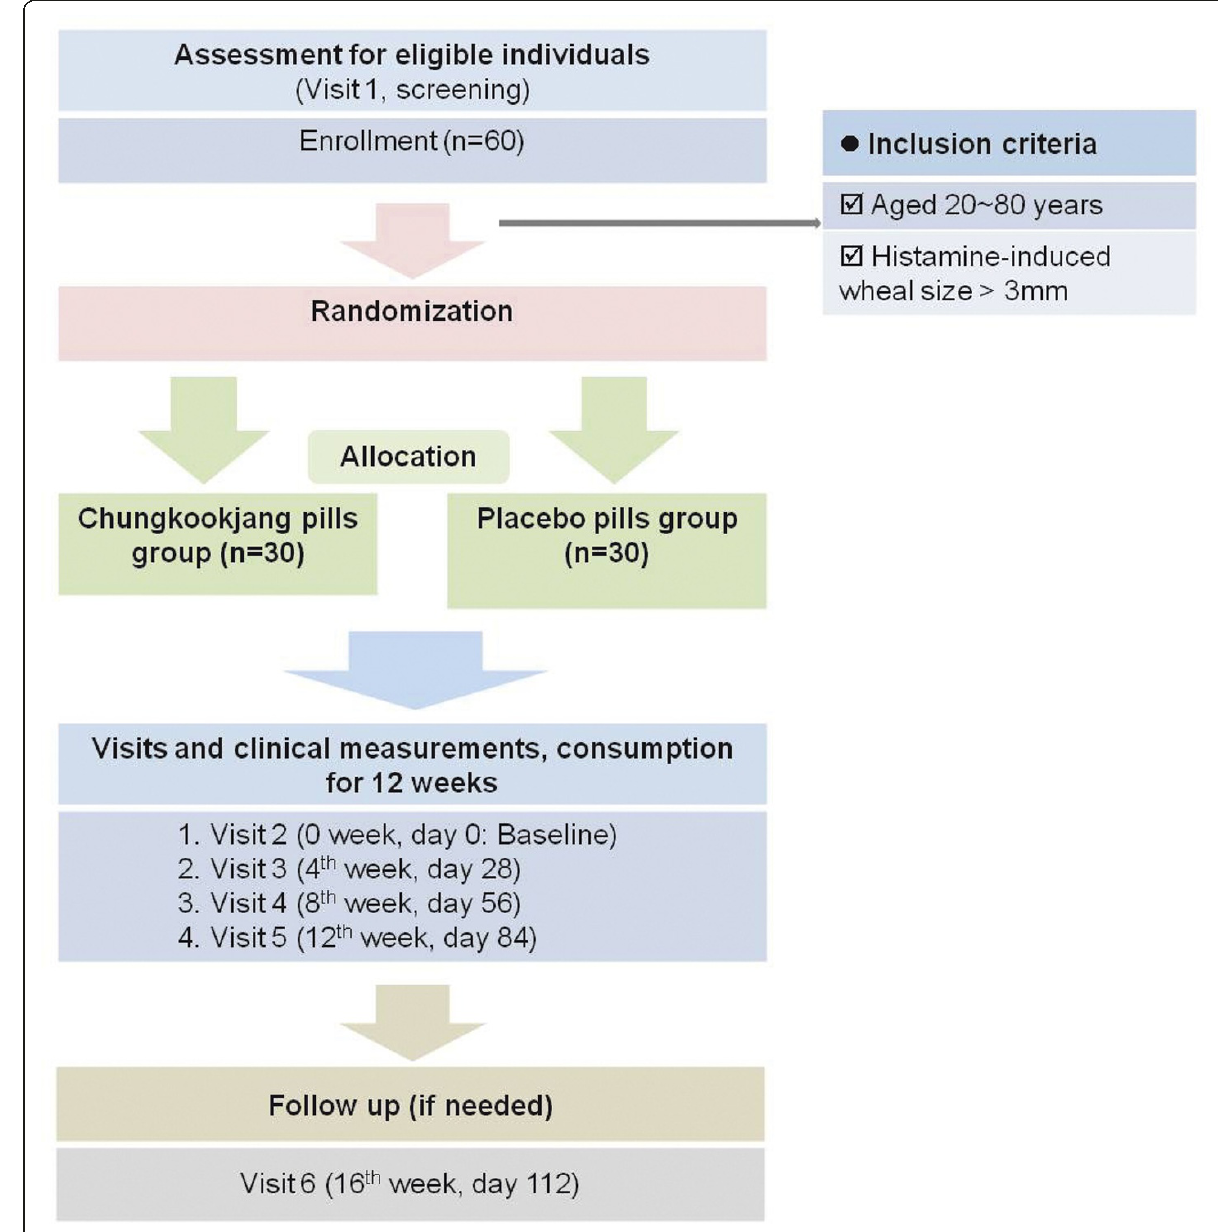
Figure 1 Flow diagram for study . Summary of the study